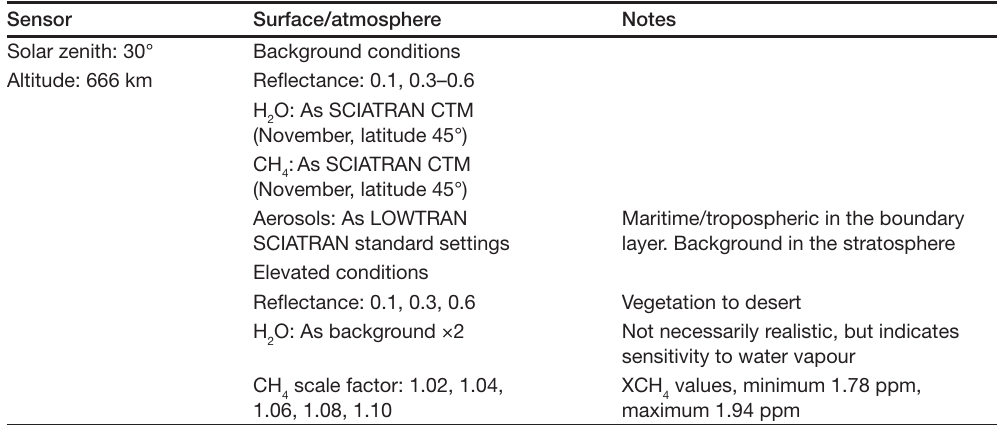
Table 2. SCiATRAN Simulation conditions for detection